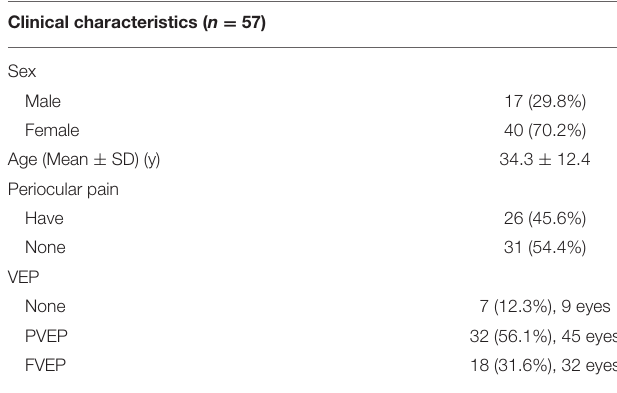
TABLE 1 | Clinical characteristics of all enrolled